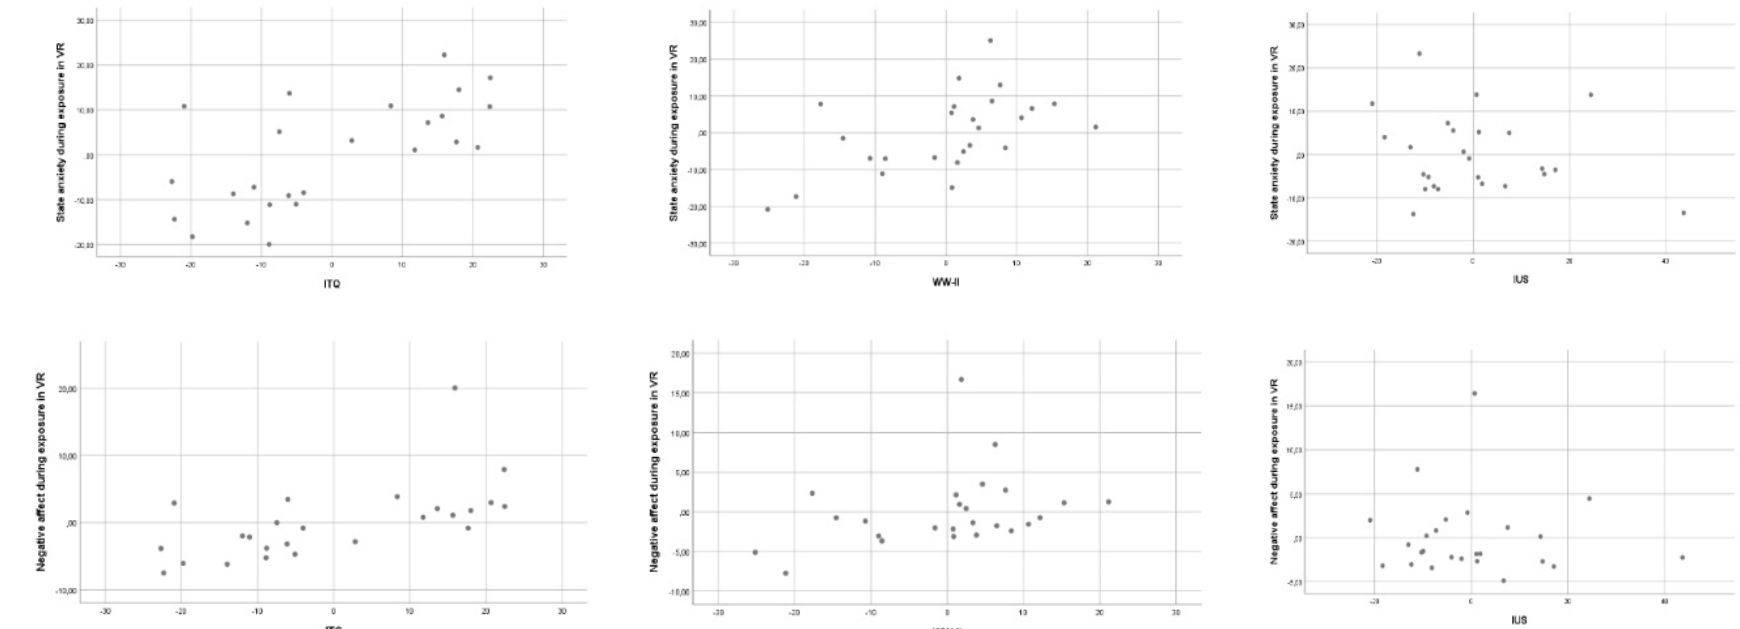
Figure 3. Scatterplots for the three predictors of state anxiety ( top three) and negative affect ( bottom three): immersive tendency (ITQ, left plot), positive beliefs about worry (WW-II, center plot), and intolerance of uncertainty (IUS, right plot).